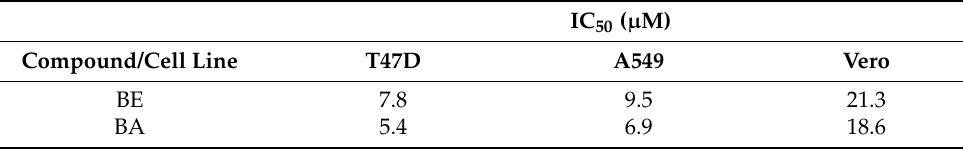
Table 1. IC 50 values of BE and BA on T47D and A549 cell lines as determined during 48 h period of MTT assay, using non-linear, four-parameter regression